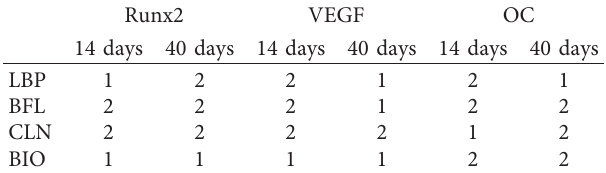
Figure 4: Representative charts showing average values and standard deviation of newly formed bone area of the experimental groups (BIO, BFL, CLN, and LBP) at 14 and 40 days postoperatively with p < 0 . 001, except for BFL and LBP at 14 days, which showed no difference ( ∗ ). Table 3: Interactions among the percentual values of new bone Table 5: Scores of immunohistochemical analysis established for formation of biomaterials used at 14-day period (Tukey test). experimental groups (Runx2, VEGF, and OC) at 14 and 40 days, showing light (1), moderate (2), or intense (3) Biomaterials